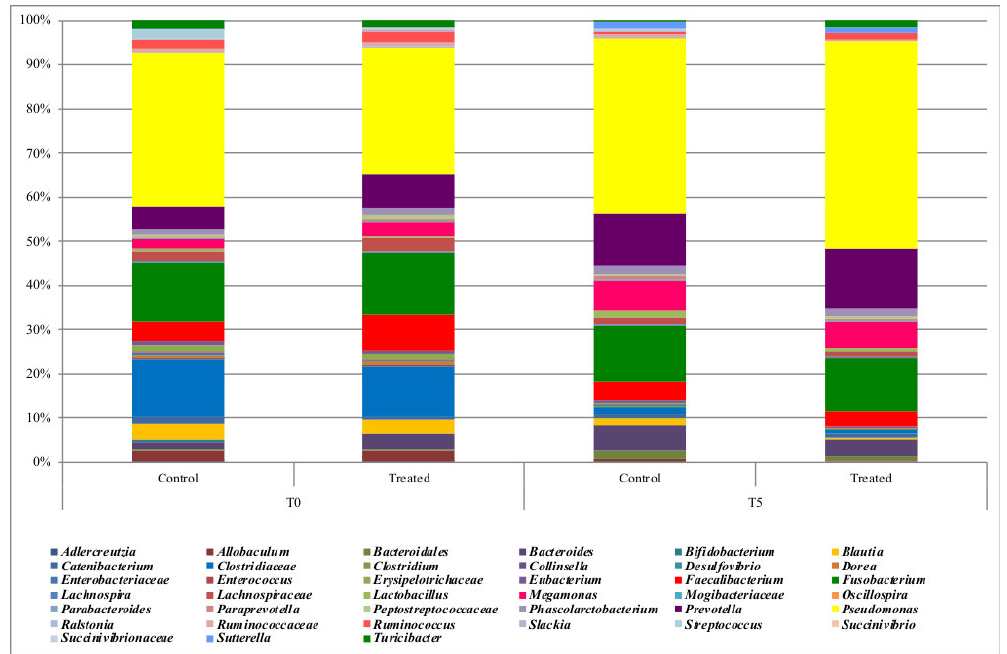
Figure 2. Relative frequency of the main bacterial ASVs in fecal samples of dogs fed with control or treated with probiotic during the trial. Graph bars indicate the 15 replicates per each sampling point.